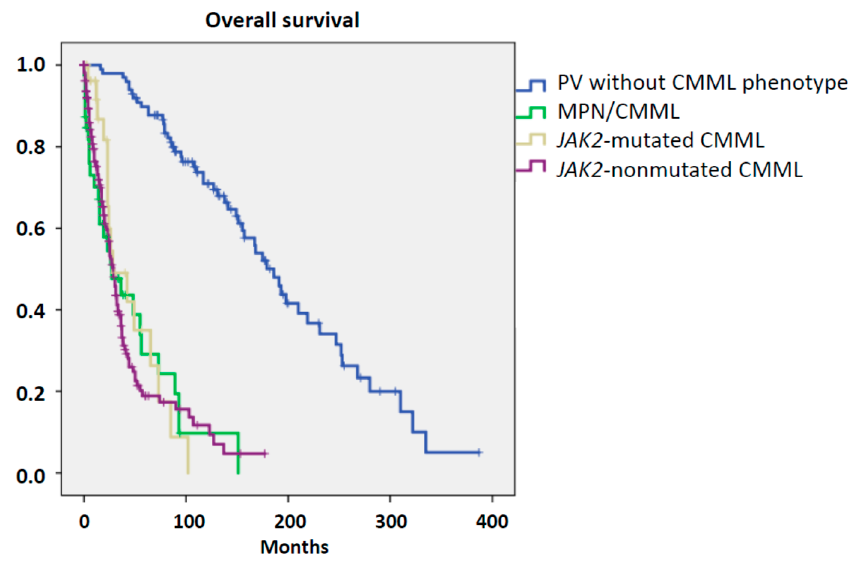
Figure 3. Overall survival in patients with myeloid disorder.